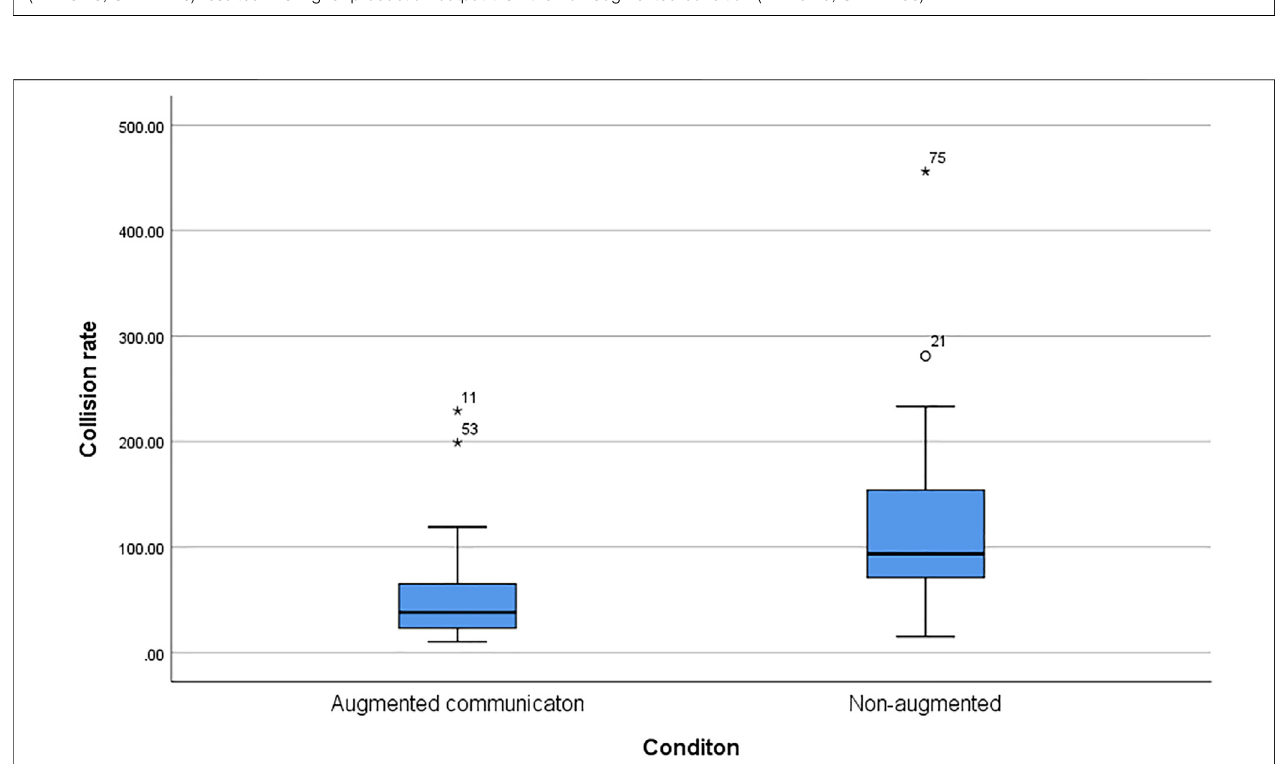
FIGURE 9 | The box plot shows the average collision rate between the robot arm and the participants for the augmented condition ( M (cid:1) 53.57, SD (cid:1) 47.40) in comparison to the non-augmented condition ( M (cid:1) 118.82, SD (cid:1) 81.49).